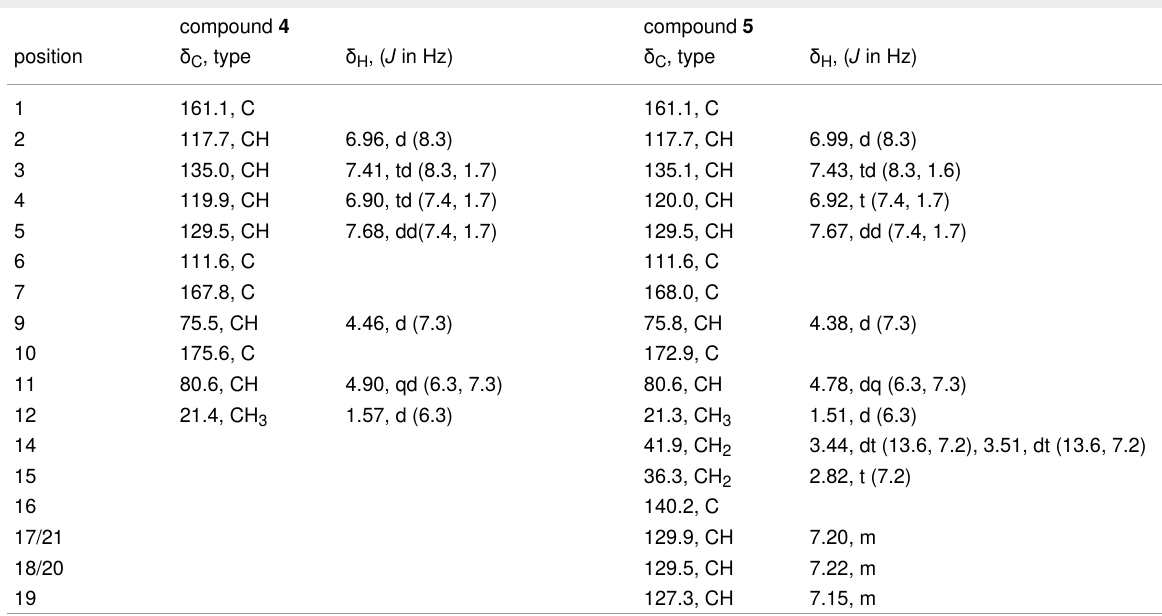
Table 2: 1 H and 13 C NMR data of pseudomobactin A ( 4 ) and B ( 5 ).